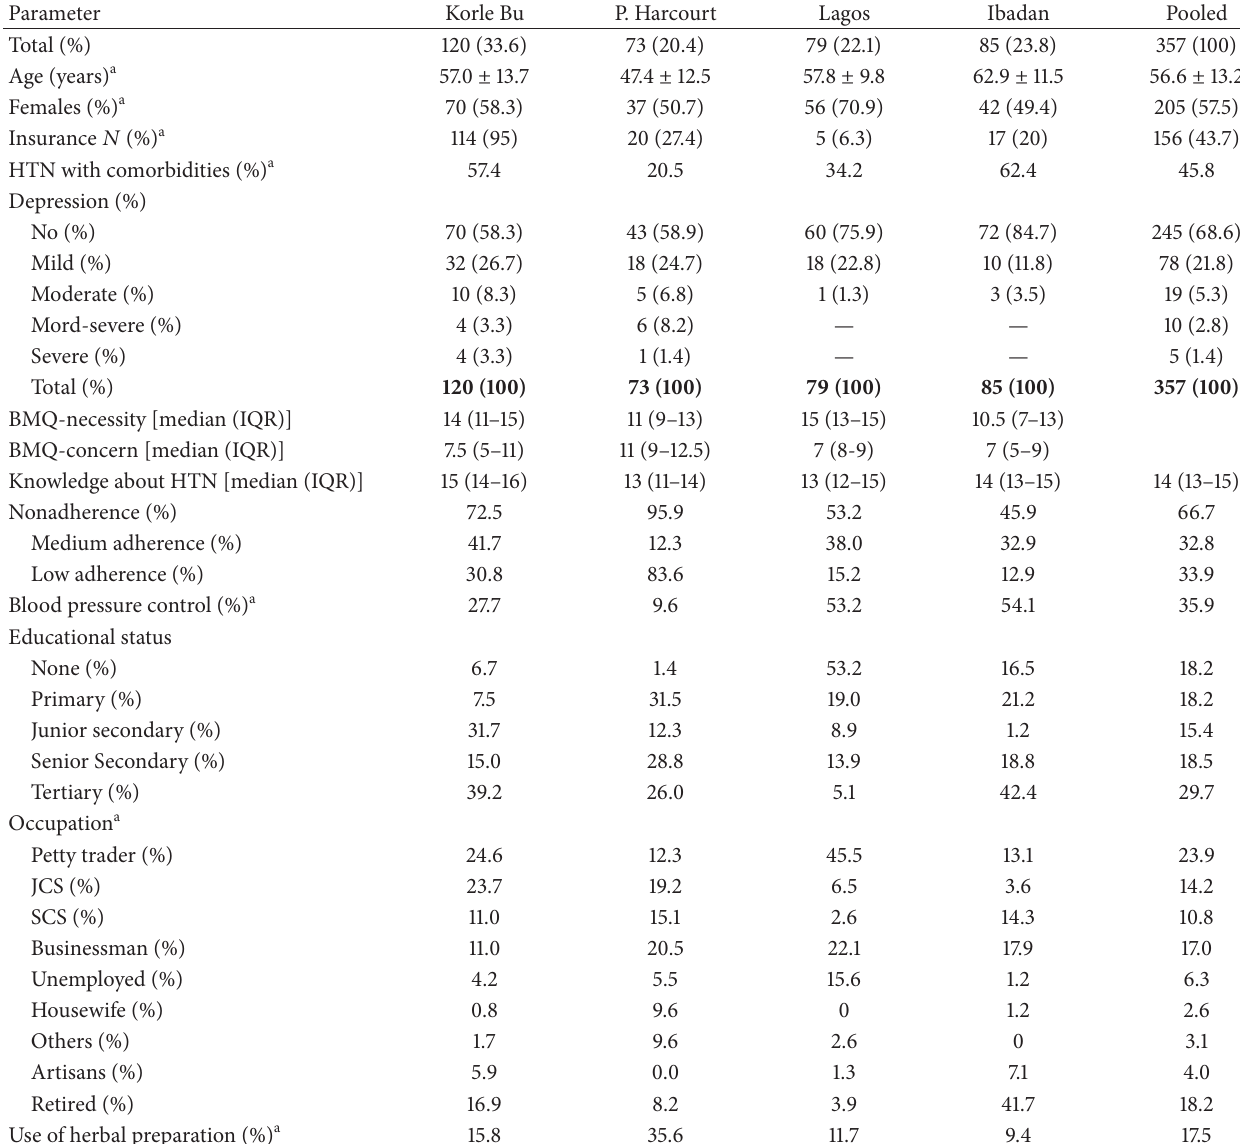
Table 1: Distribution of study population characteristics by